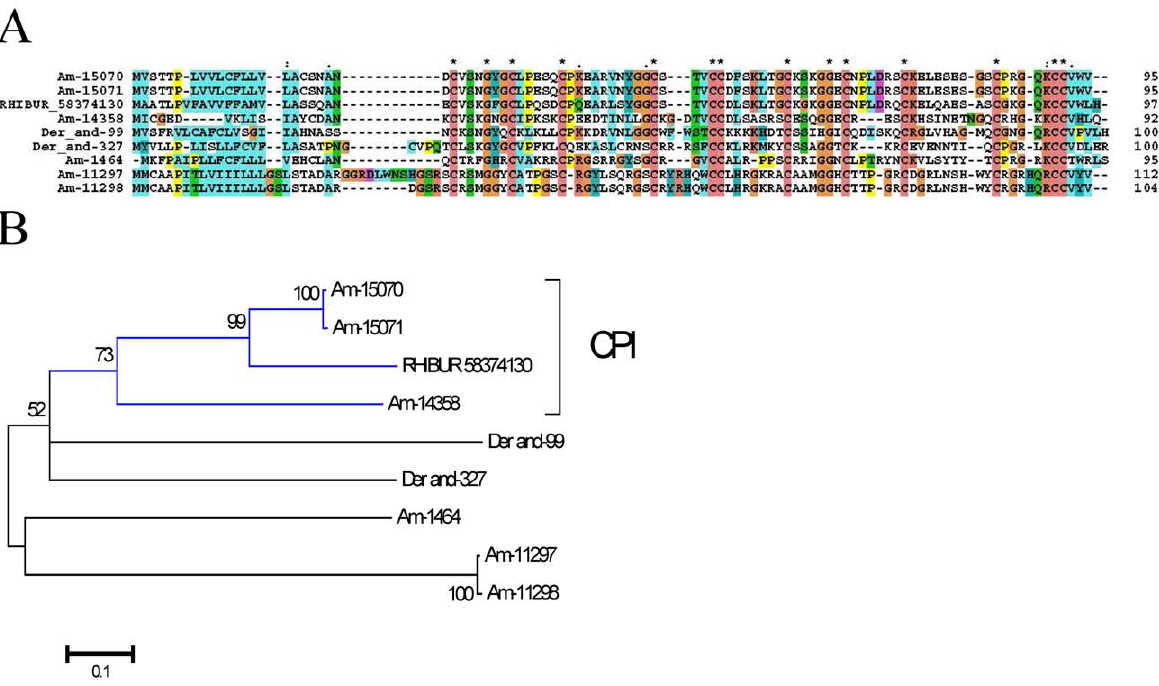
Figure 3. The tick salivary carboxypeptidase inhibitor family of proteins. ( A ) Alignment of Amblyomma maculatum , Dermacentor andersoni , and Rhipicephalus bursa proteins. ( B ) Bootstrapped phylogram (1,000 iterations) resulting from the alignment in ( A ). The numbers on the nodes indicate the bootstrap support above 50%. The clade indicated by CPI contains the functionally characterized R. bursa protein. The bar at the bottom indicates 10% amino acid divergence. The Dermacentor proteins were deducted from ESTs deposited in DBEST.